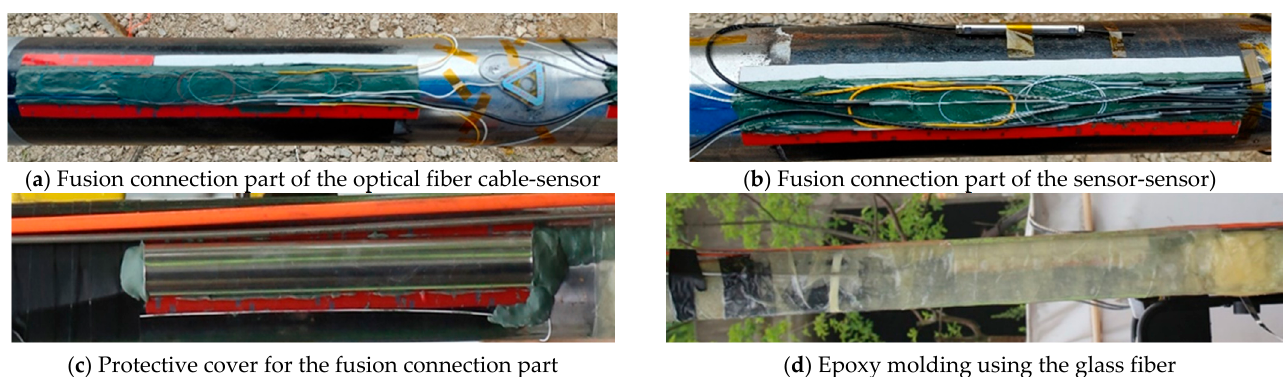
Figure 7. Protection method for the optical fiber fusion connection part: ( a ) Optical fiber cable-sensor fusion connection part (Figure 2 ➀ ); ( b ) Sensor-sensor fusion connection part (Figure 2 ➂ ); ( c ) Protective cover for the fusion connection part; ( d ) Epoxy molding using the glass fiber.